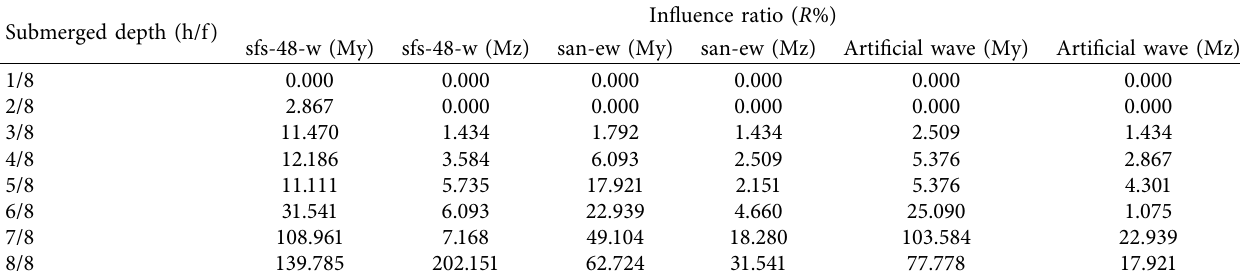
Table 4: Te relation of R and submerged depth at 2L/16 of the arch.